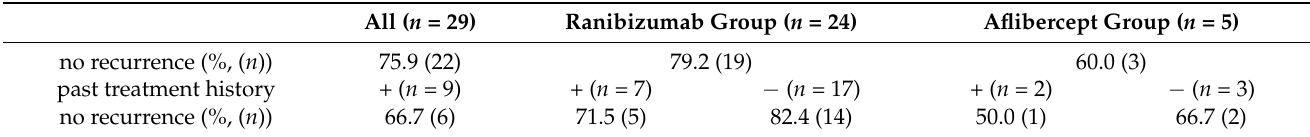
Table 3. No recurrence rate during the 1 year follow up divided into anti-VEGF